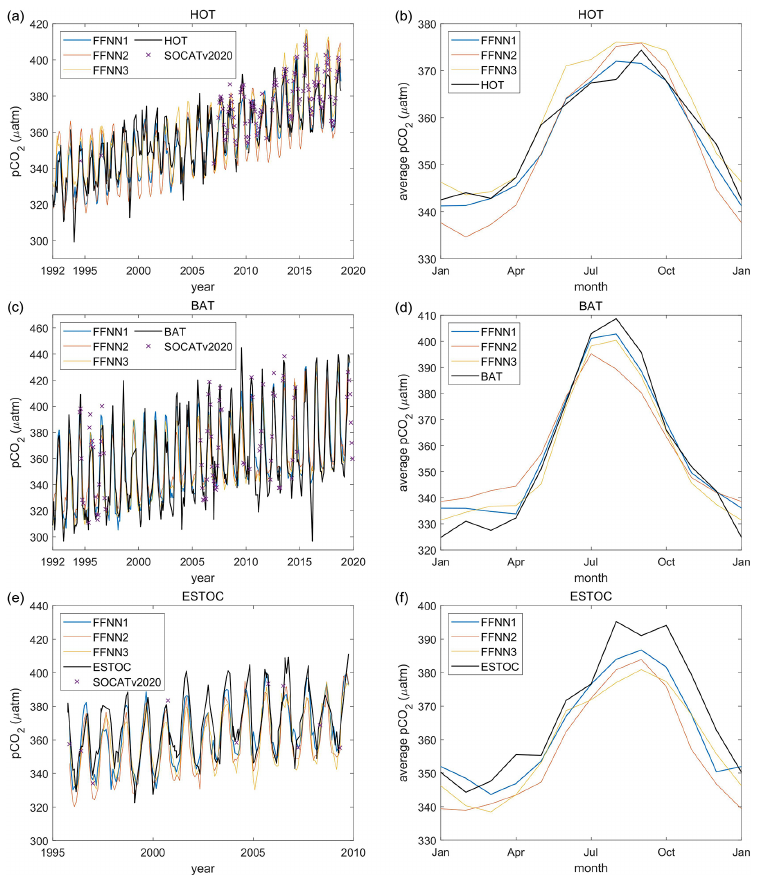
Figure 8. Validation based on independent observation from time series stations: (a,b) the Hawaii Ocean Time-series (HOT; Dore et al., 2009); (c,d) the Bermuda Atlantic Time-series Study (BATS; Bates, 2007); (e,f) the European Station for Time Series in the Ocean Canary Islands (ESTOC; González-Dávila and Santana-Casiano, 2012). FFNN1 was based on predictors selected by the stepwise FFNN algorithm. FFNN2 and FFNN3 were based on predictors from Landschützer et al., 2014 and Denvil-Sommer et al., 2019, respectively. SOCATv2020 represents the monthly mean p CO 2 of SOCAT observations in the corresponding grids of each time series